Question: Draft a figure caption describing what is shown.
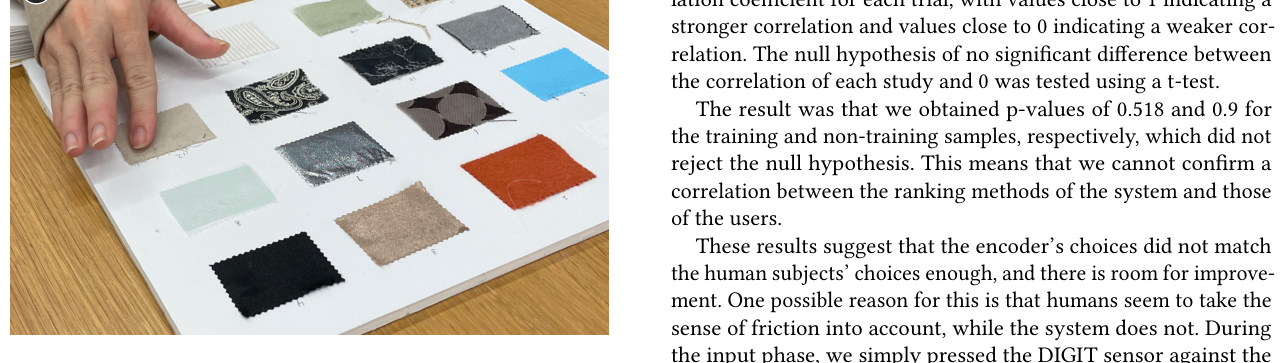
Answer: User Experiment. Subjects were asked to perform the following procedures three times. (a) Subjects select a pattern from [29], which includes the samples used to train our model, or [20], which includes samples not used to train the model, and touch it. (b) They then touch 16 different patterns that we have implemented on the actuator and select the five patterns that feel closest to their chosen fabric.